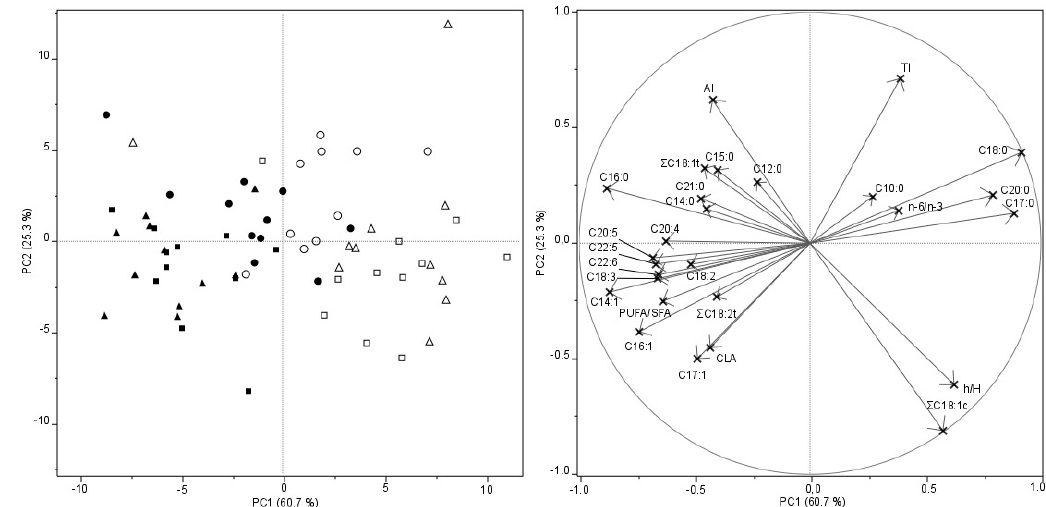
Figure 1. Left: PCA scores plot of intramuscular (IM) and subcutaneous (SC) fat samples. Symbols are: Bergamasca, IM; Sopravissana, IM; Italian Merino, IM; Bergamasca, SC; Sopravissana SC; Italian Merino, SC. Right: PCA loadings plot of variables (individual and ratios).